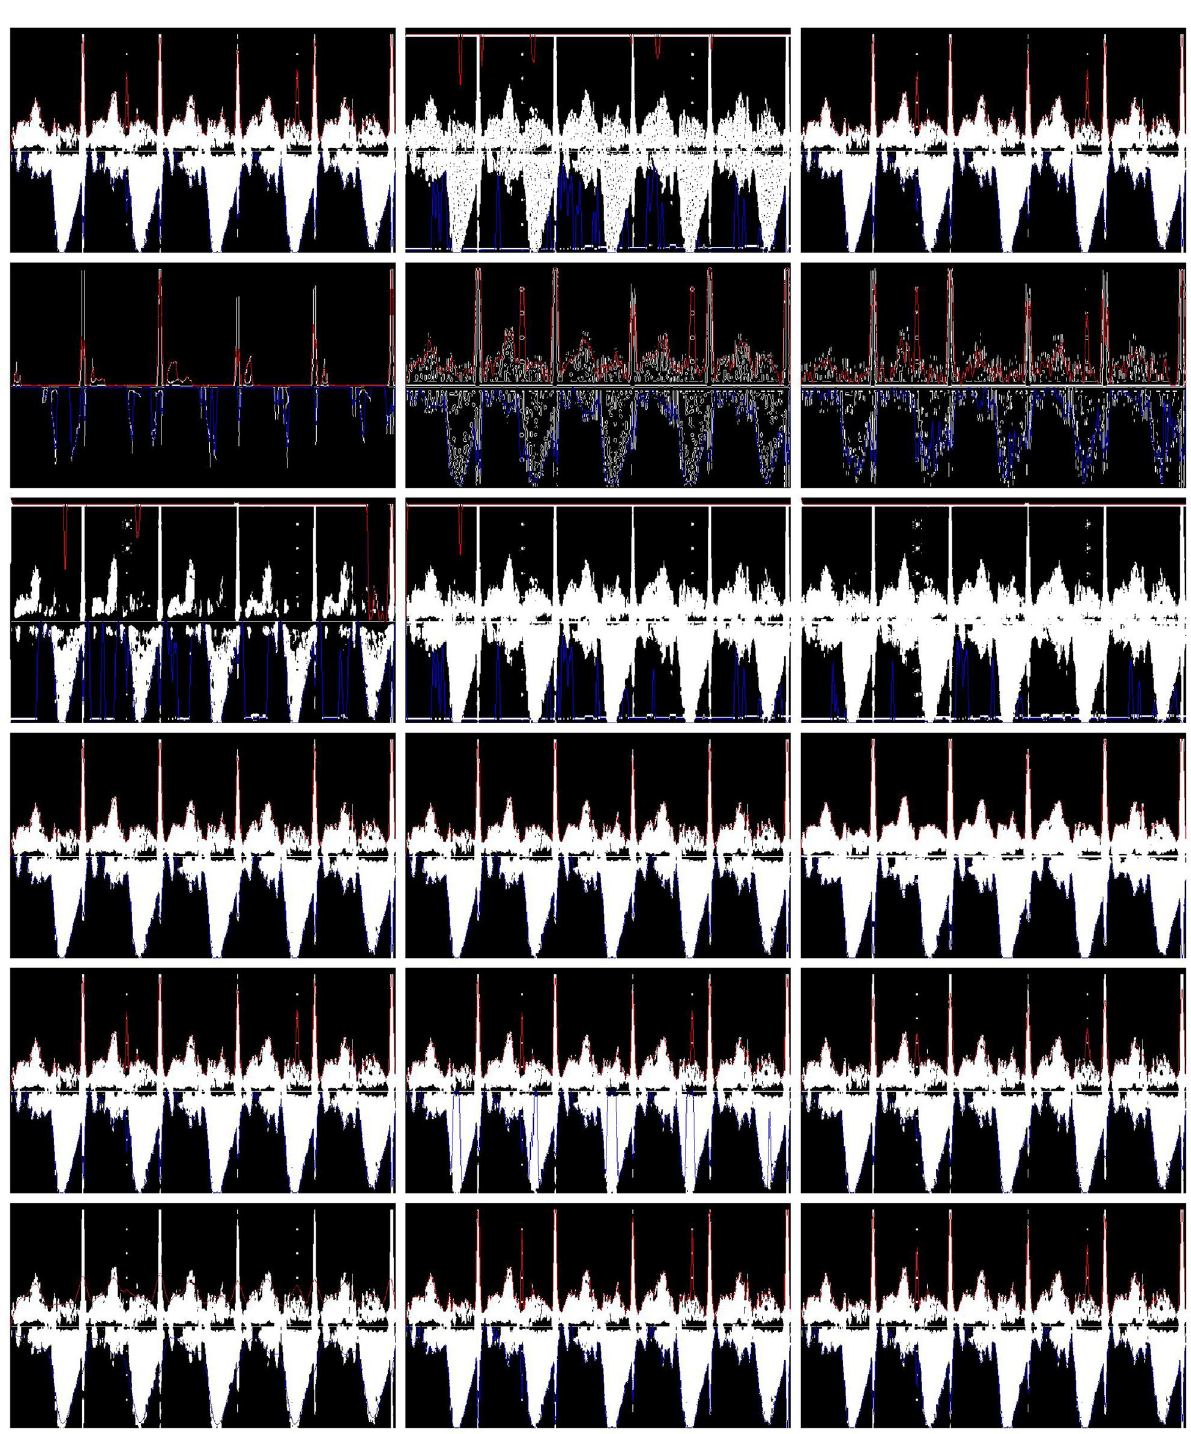
Fig 7. Example of output images. Each image presents envelopes (upper envelopes (red) and lower envelopes (blue)) and a binarized image, as obtained by the different signal processing chains listed in Table 2, for the same five fetal beats. From left to right, and top to bottom, the processing chains are identified by numbers 1 to 17 in Table 2. The last image was obtained using the MC.